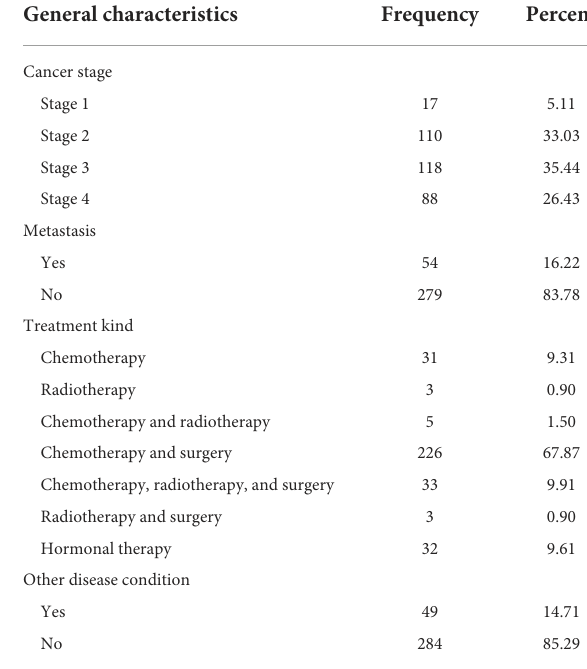
TABLE 1 The socio-demographic, economic, financial support, emotional support, and communication-related characteristics of patients with breast cancer.